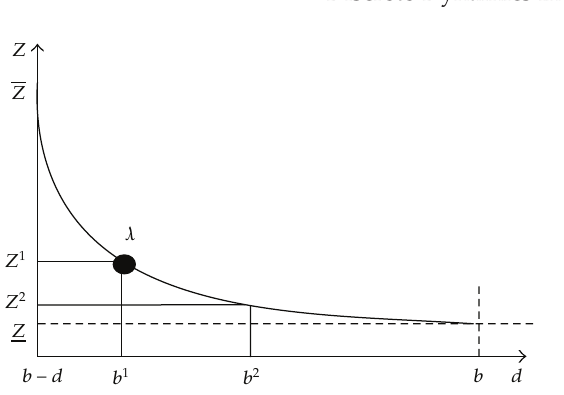
Figure 2: The principle of the fuzzy